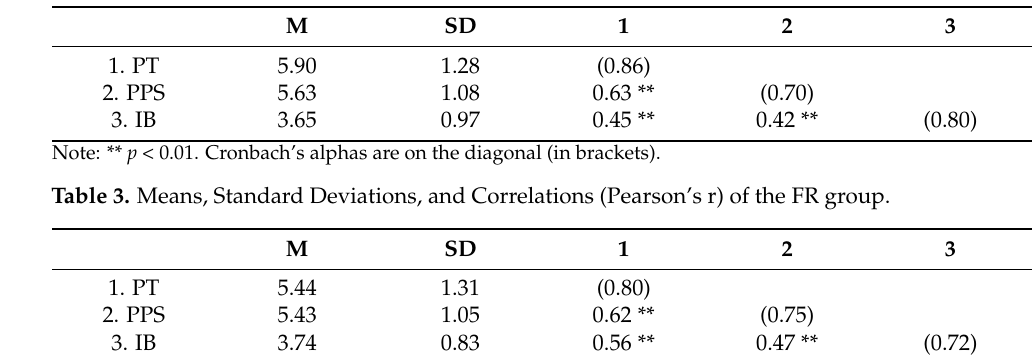
Table 2. Means, Standard Deviations, and Correlations (Pearson’s r) of the IT group.